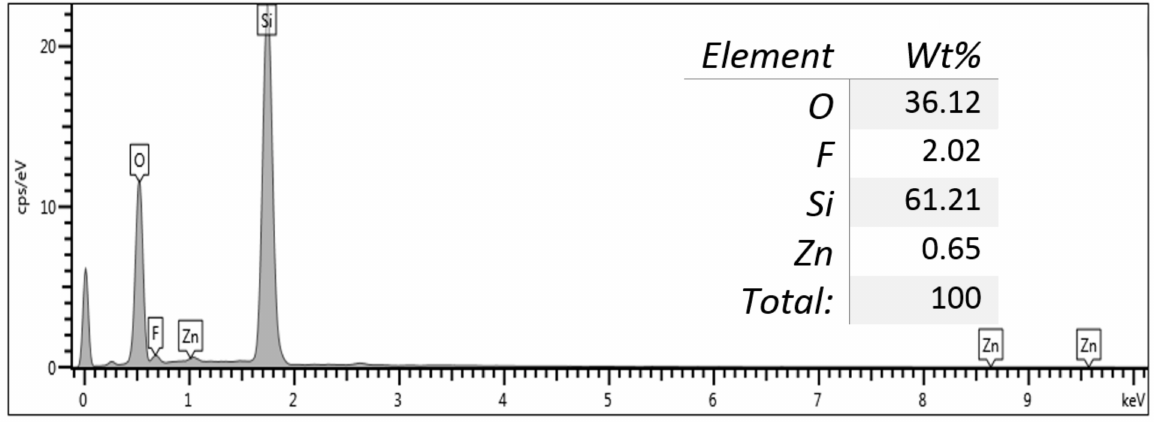
Figure 6. EDX images of the prepared ZnPSi with 0.17 g of included